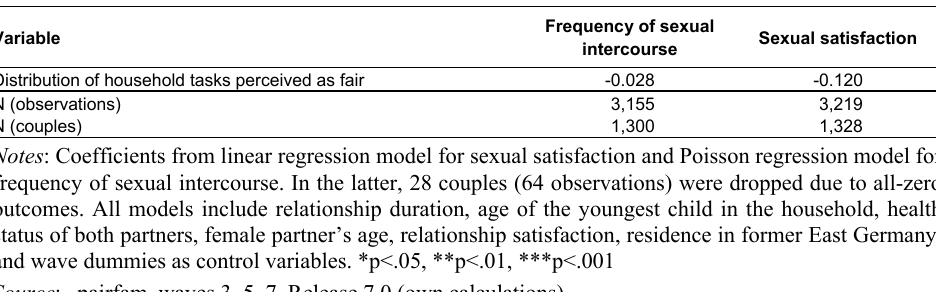
Table A.8 : Summary of fixed effects regression analyses estimating frequency of sexual intercourse and sexual satisfaction with same variables as Johnson and col- leagues (2016)